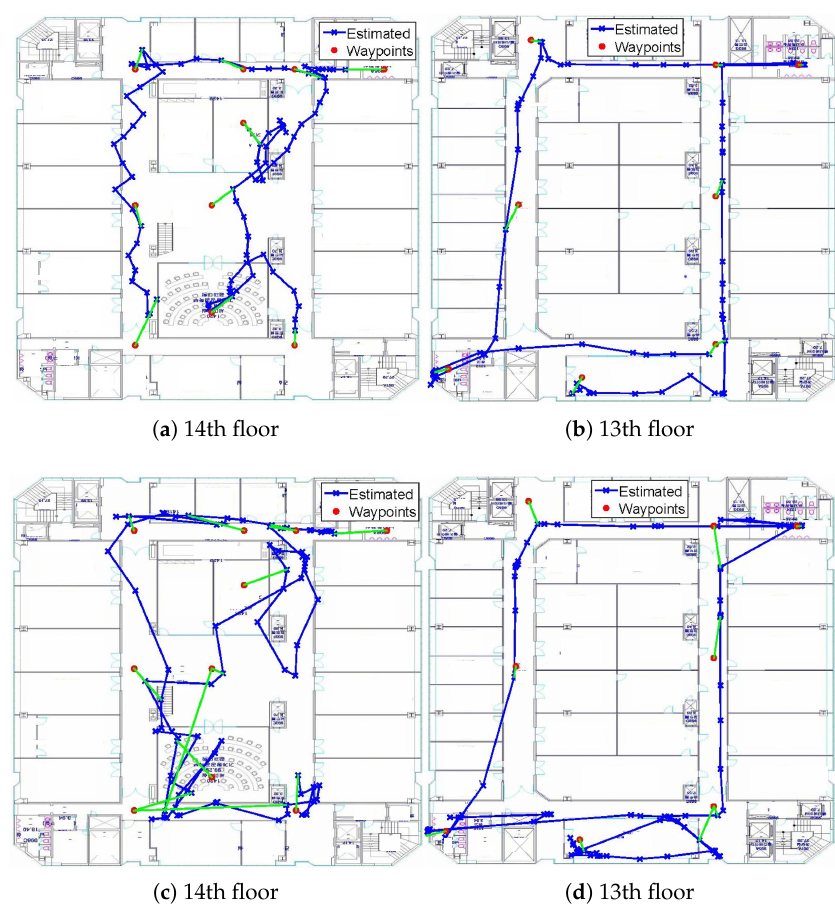
Figure 8. Positioning results with the trajectory learning ( a , b ) and without the trajectory learning ( c , d